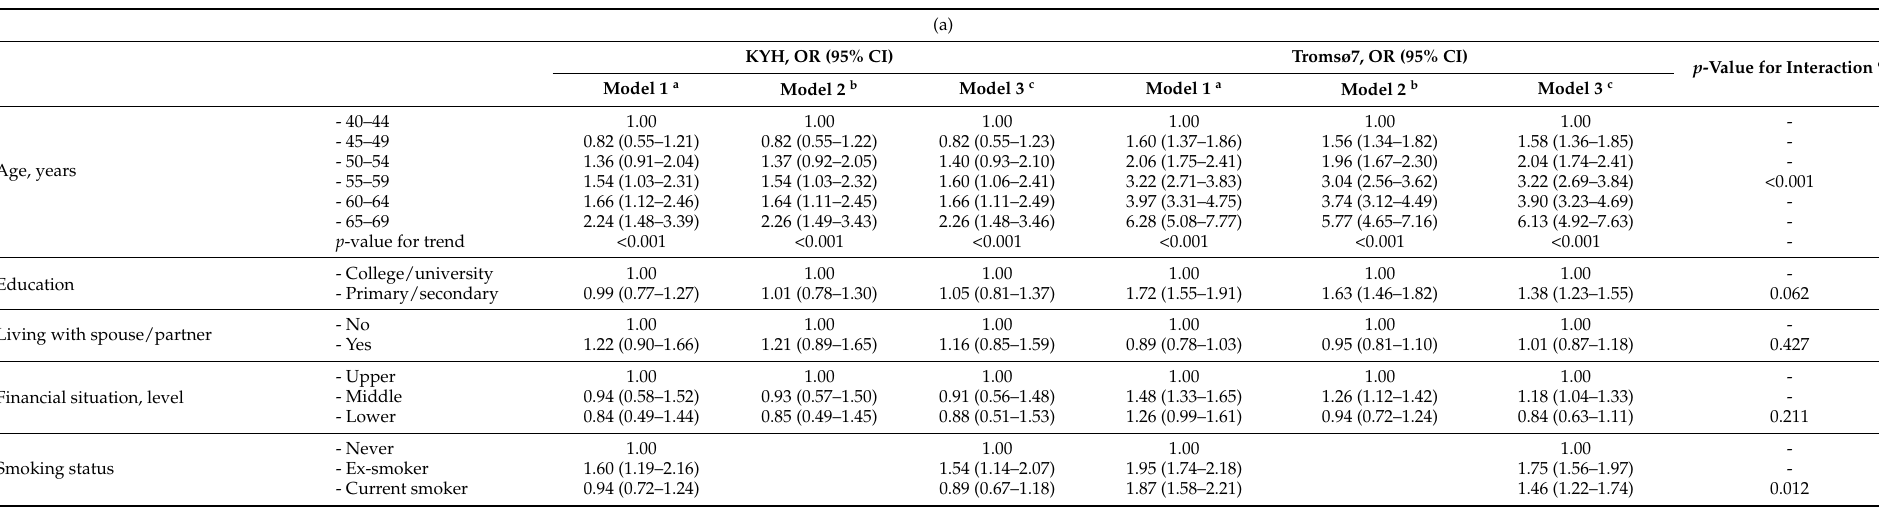
Table 3. (a) Associations of socio-demographic and behavioral characteristics with abdominal obesity (WHR > 0.9) by study among men. (b) Associations of socio-demographic and behavioral characteristics with abdominal obesity (WHR > 0.85) by study among